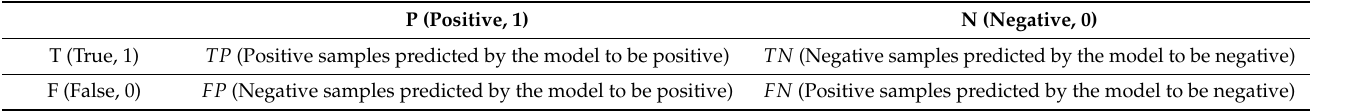
Table 8. Specific